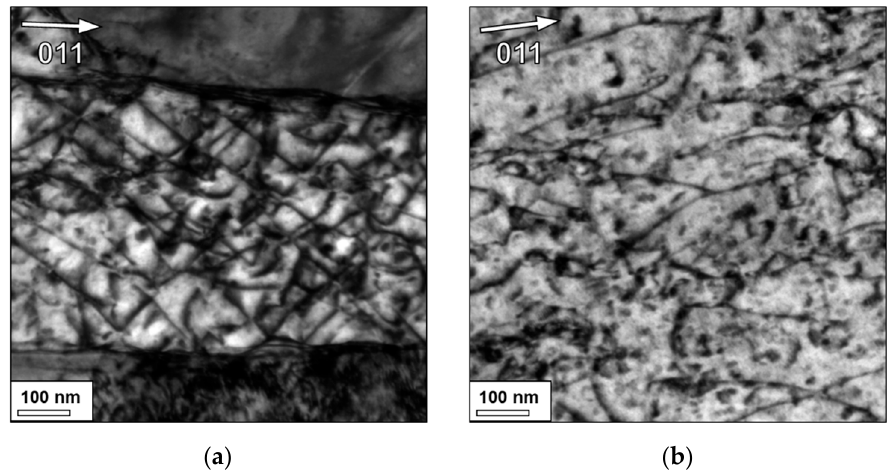
Figure 9. Bright-field TEM images of the 14YWT tubing used in this study, showing a possibly greater dislocation density in as-pilgered base material ( a ) than in post-CDRW material within 20 µ m of a joint ( b ) formed using Weld Condition 3. The g = (cid:104) 011 (cid:105) diffraction vector was excited for imaging.